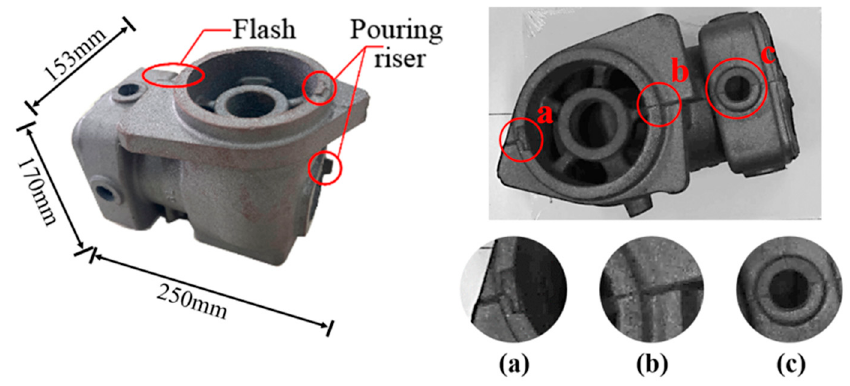
Figure 1. Physical drawing of casting. ( a ) Pouring riser area. ( b ) Flash area. ( c ) Flash area. (2)